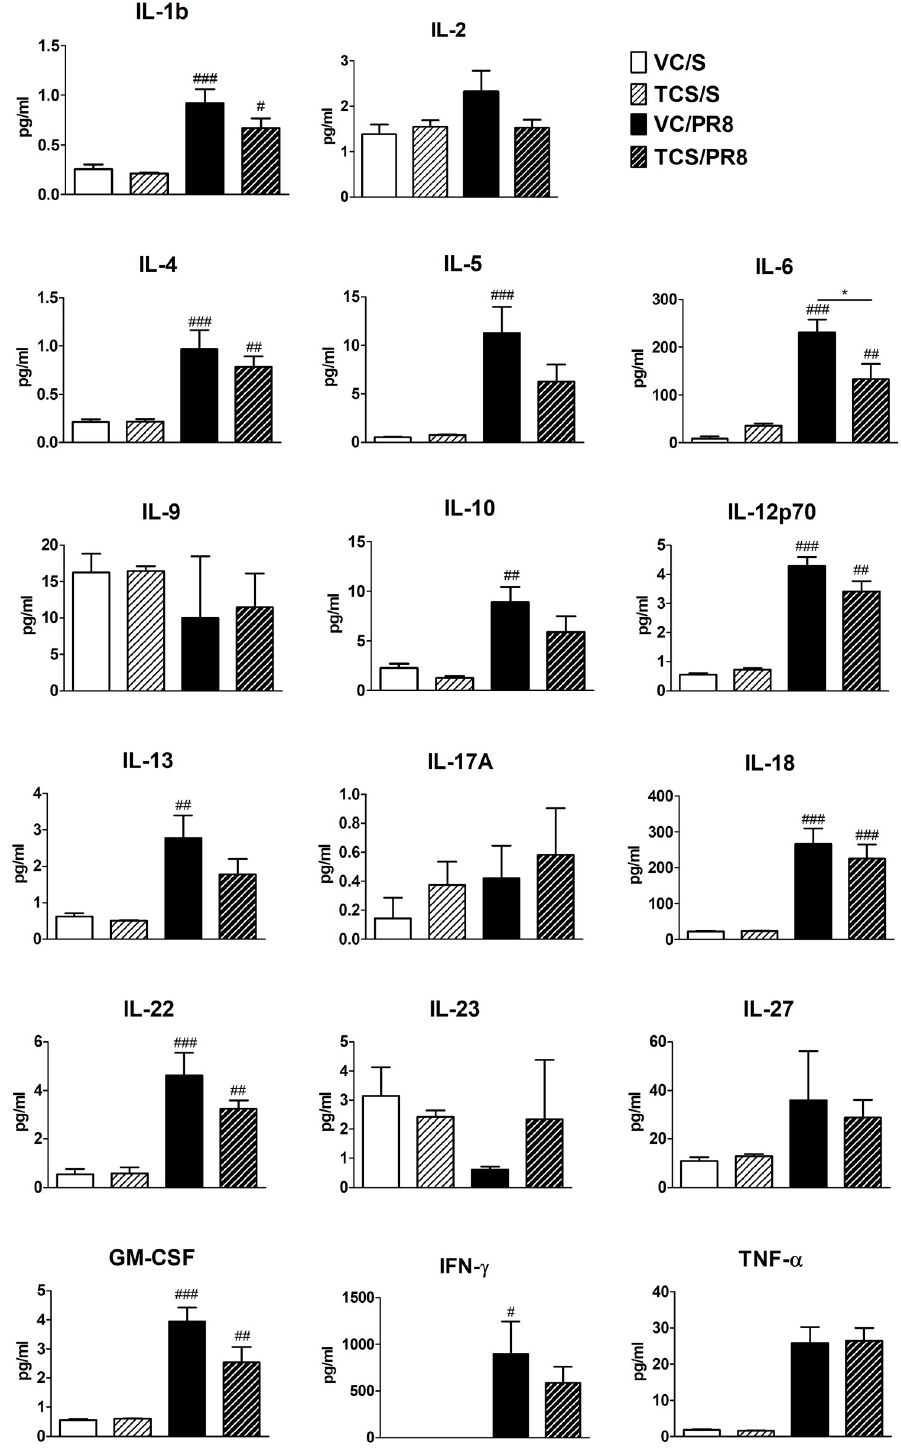
Fig 3. Cytokine expression in BALF. Cytokine expression was measured by Luminex assay in the first fraction of BALF isolated from mice at 10 dpi for each of the treatment groups, VC/S (white bars), TCS/S (light striped bars), VC/ PR8 (black bars), and TCS/PR8 (dark striped bars). #s indicate significance as compared the VC/S control as determined by one-way ANOVA followed by a Dunnett’s post-test. � s indicate significance values determined using an unpaired student’s t-test between the VC/PR8 and TCS/PR8 groups. #/ � = P < 0.05, ## = p < 0.01, ### = p < 0.001; n = 5 mice per group. https://doi.org/10.1371/journal.pone.0244436.g003 PLOS ONE | https://doi.org/10.1371/journal.pone.0244436 December29,